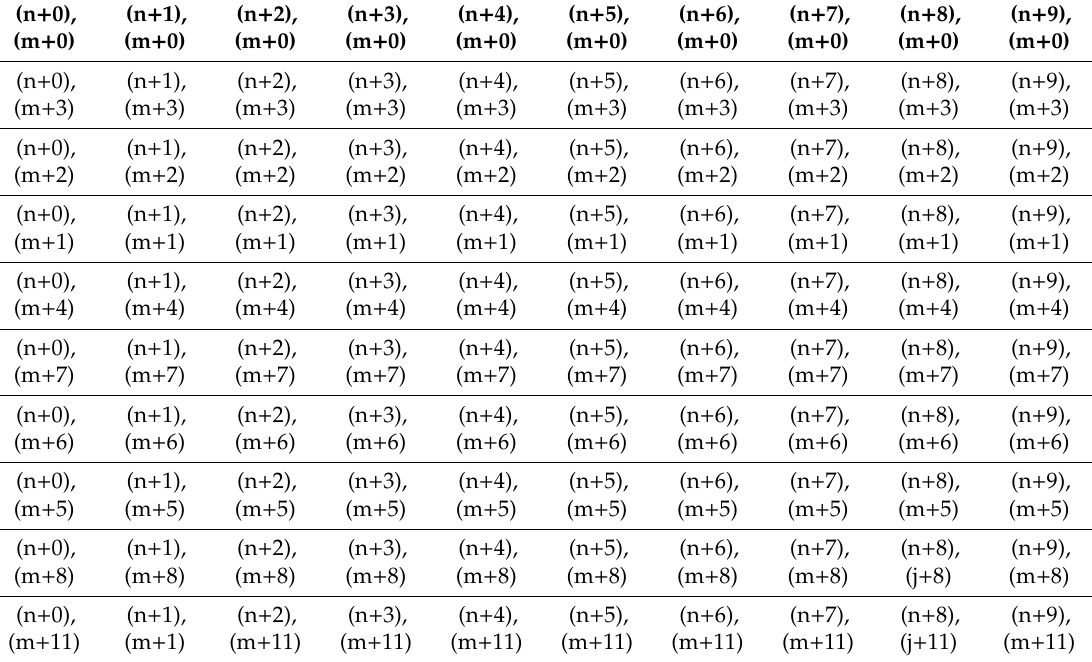
Figure 11. Cellular grid of a 5 × 5 matrix colored using the L(3,1) coloring.